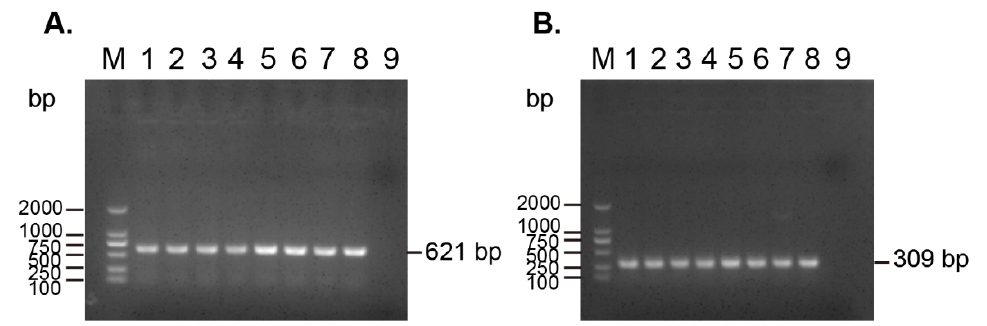
Figure 2. PCR detection of the carbapenem-resistant gene bla NDM-1 and the colistin-resistant gene mcr-1 from ( A ) the plasmids extracted from the eight carbapenem-resistant and ( B ) the colistin-resistant E. coli strains. M: DL 2000 DNA marker; 1–8: plasmid from RXD007, RXD012, RXD020, RXD024, RXD033, RXD035, RXD100, and RXD115; 9: ddH 2 O as negative control.